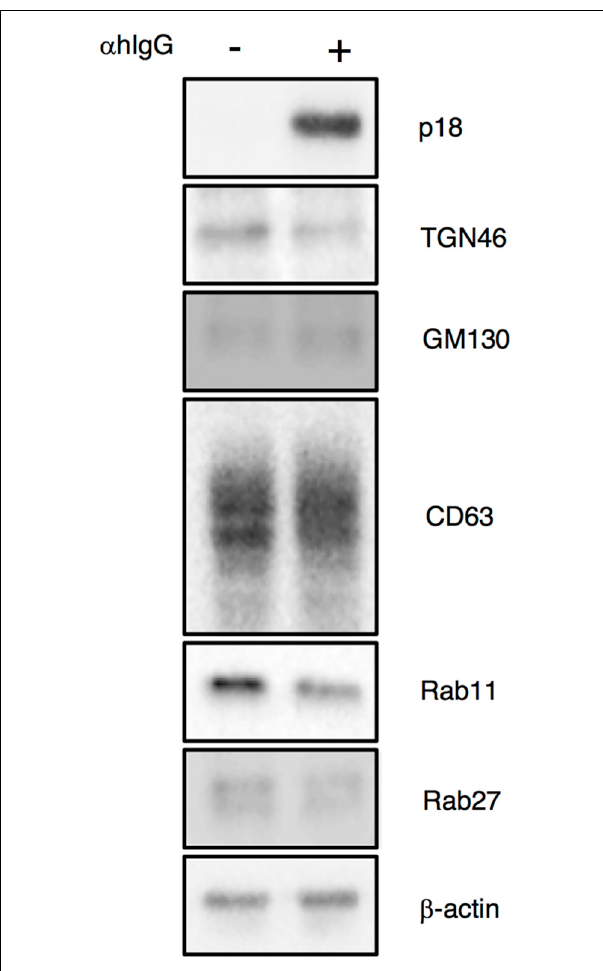
FIGURE 7 | Expression of organelle markers in Akata + cells treated with α hIgG. Akata + cells were treated with or without α hIgG for 16 h. Total cell lysates were analyzed by Western blotting with antibodies against p18, TGN46, GM130, CD63, Rab11, Rab27a, or β -actin.